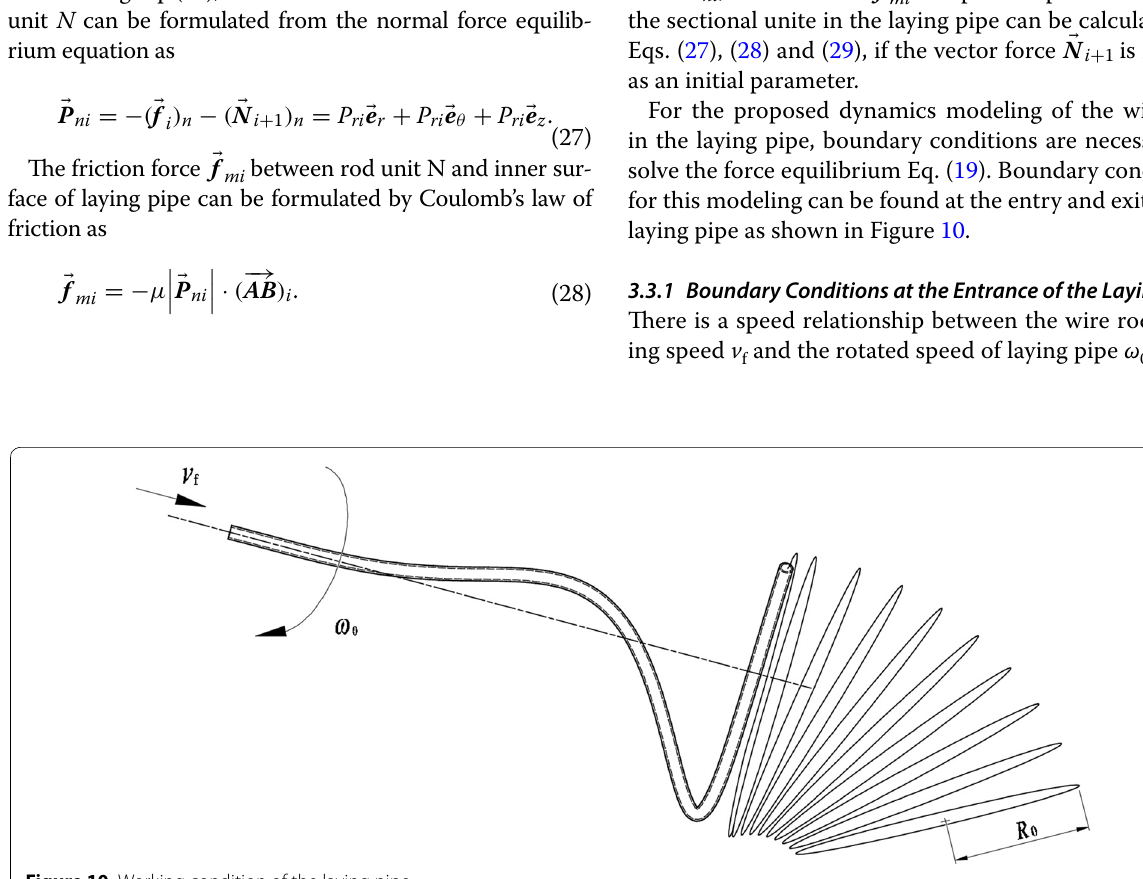
Figure 10 Working condition of the laying